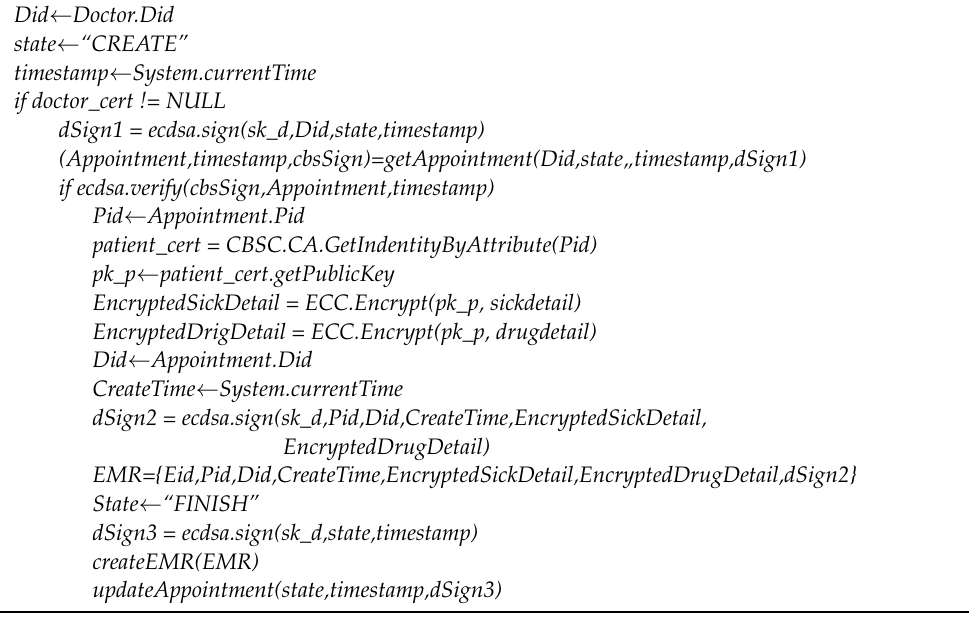
Algorithm 4. The chaincode of the pseudo-code of EMR